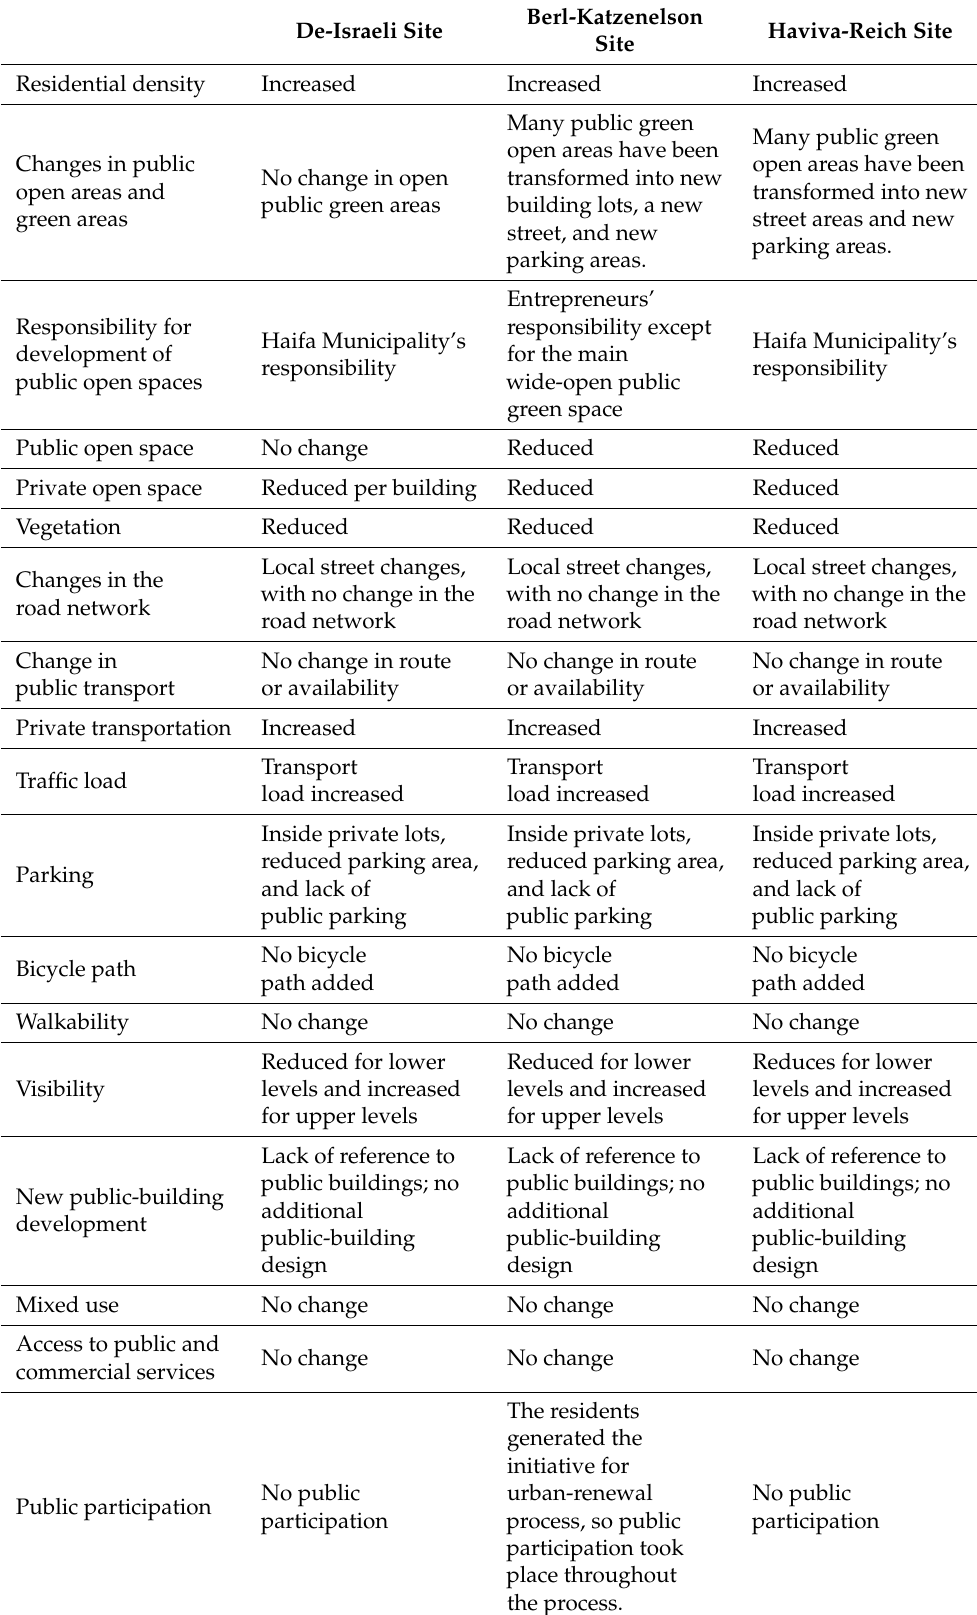
Table 2. Presents the comparable evaluation quality parameters for the urban environmental quality